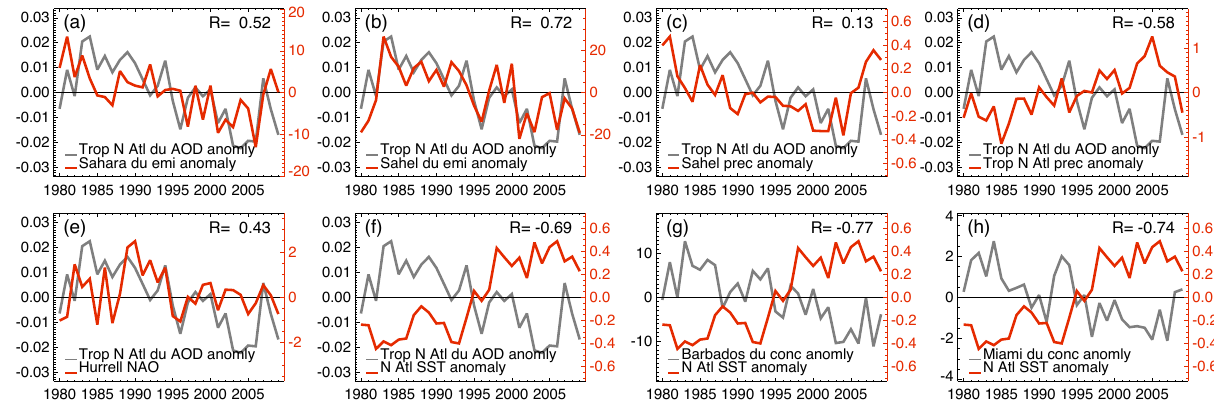
Fig. 14. From (a) to (e) : time series of GOCART-calculated tropical North Atlantic (5–20 ◦ N, 90–18 ◦ W) dust AOD anomaly (dark grey line) vs. (red line) model-calculated Sahara dust emission anomaly (a) , model-calculated Sahel dust emission anomaly (b) , MERRA Sahel precipitation anomaly (c) , MERRA tropical North Atlantic precipitation anomaly (d) , Hurrell principle component-based NAO index (http:// climatedataguide.ucar.edu/guidance/hurrell-north-atlantic-oscillation-nao-index-pc-based) (e) , and MERRA North Atlantic (0–66 ◦ N) SST anomaly (f) . From (g) to (h) : time series of GOCART-calculated Barbados (g) and Miami (h) dust concentration anomaly vs. North Atlantic SST anomaly. Anomaly is defined as the difference between the annual average value and the 30-year